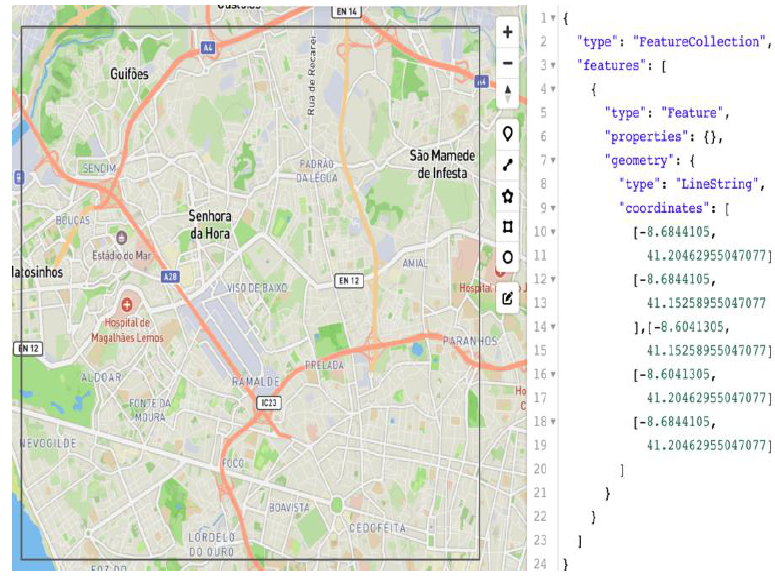
Figure 8. Porto segmented into sixteen cells of the grid. Figure 8 . Porto segmented into sixteen cells of the grid.